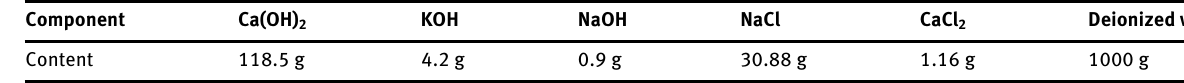
Table 2: Chemical compositions of artificially simulated alkali-salt solution.